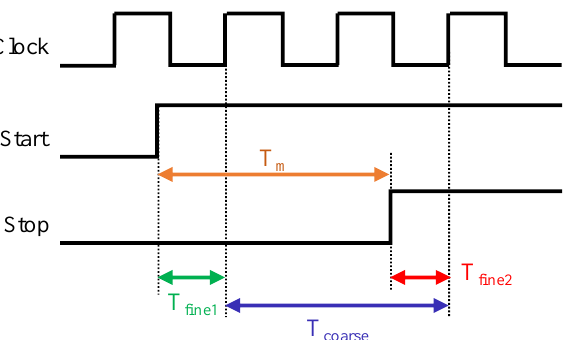
Figure 6. Asynchronous TDC chronogram. The time interval between two asynchronous signals to the system clock is calculated from three parts: two fine intervals and a coarse one.